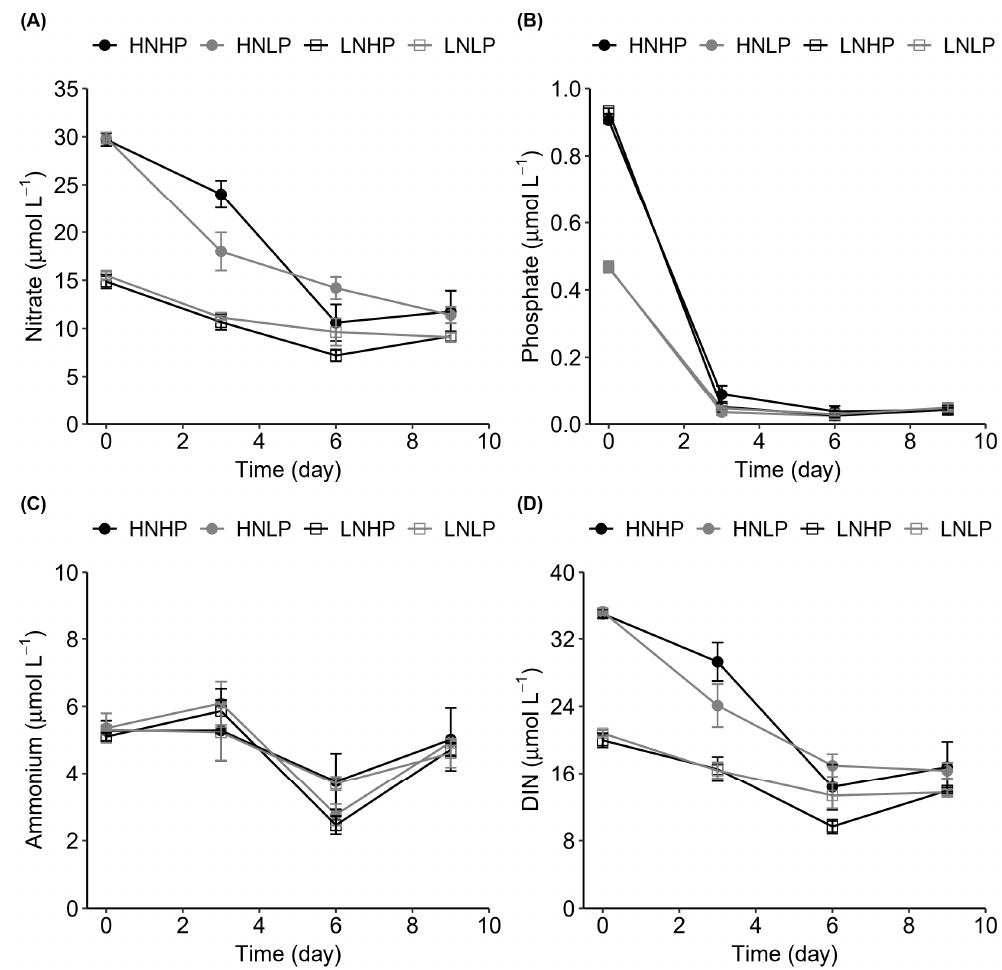
Figure 2. Nutrient concentration ( μ mol L − 1 ) changes in the cultures under the four nutrient scenarios. ( A ) Nitrate; ( B ) Phosphate; ( C ) Ammonium; ( D ) Dissolved inorganic nitrogen (DIN). The error bar represents the standard error (number of samples = 3).